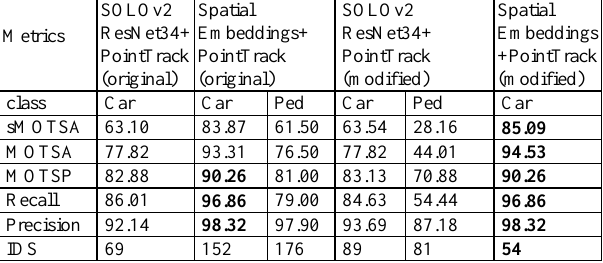
Table 1. Quality comparison between methods through classes on KITTI MOTS validation